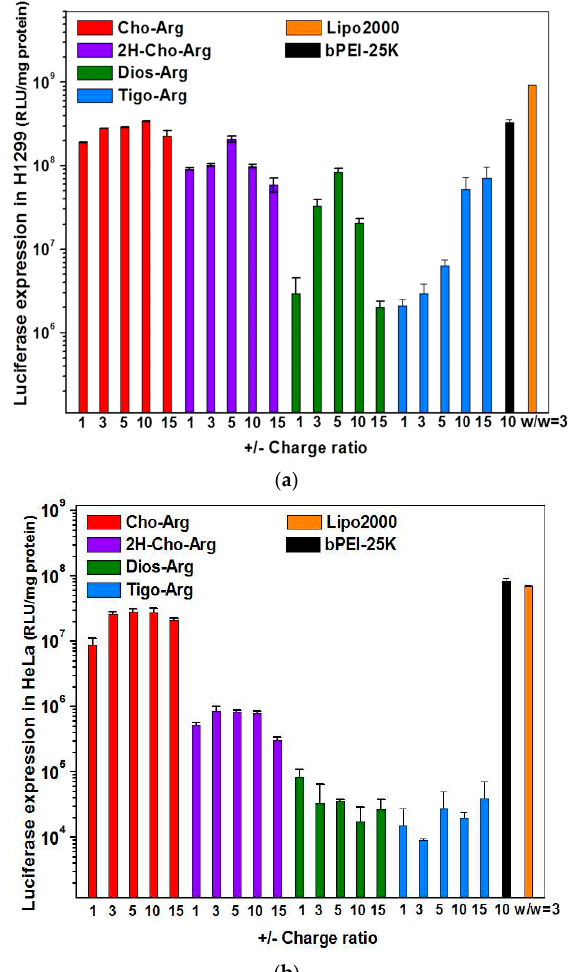
Figure 3. Luciferase gene transfection efficiency for the steroid-based cationic lipids/pDNA lipoplexes under various +/ − charge ratios in: ( a ) H1299; and ( b ) HeLa cell lines. Commercially available bPEI-25K and Lipo2000 were used as controls.